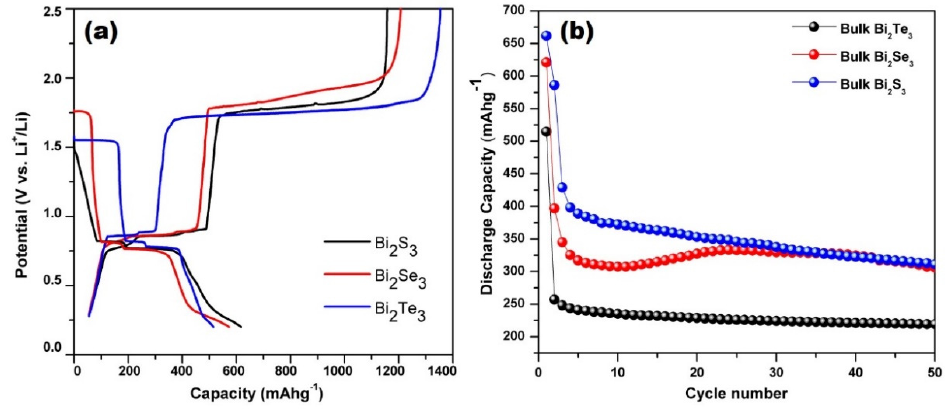
Figure 9. ( a ) First galvanostatic charge-discharge capacity of bulk Bi 2 X 3 in the voltage range 0.2–2.5 V at the 0.1C rate; ( b ) Cyclic capacity of Bi 2 X 3 up to 50 cycles. Table 1. Comparitive of discharge and cyclic capacities of different bismuth chalcogenide bulk and nanostructures